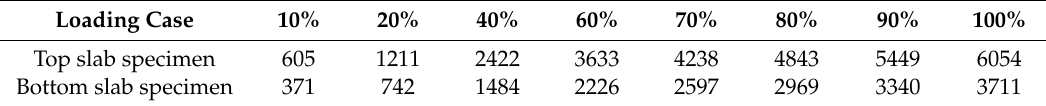
Table 2. Loading forces of the specimens (Unit: kN).